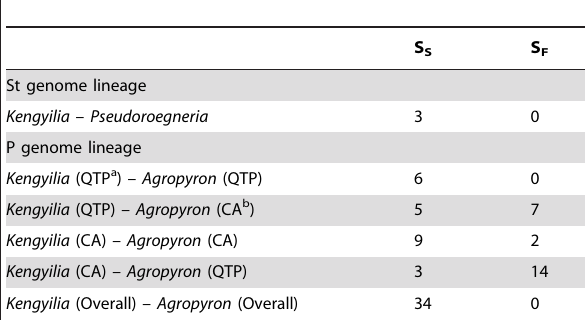
Table 1. Estimation of shared polymorphisms and fixed differences between Kengyilia and its putative diploid genome donor based on the Pgk1 sequences.